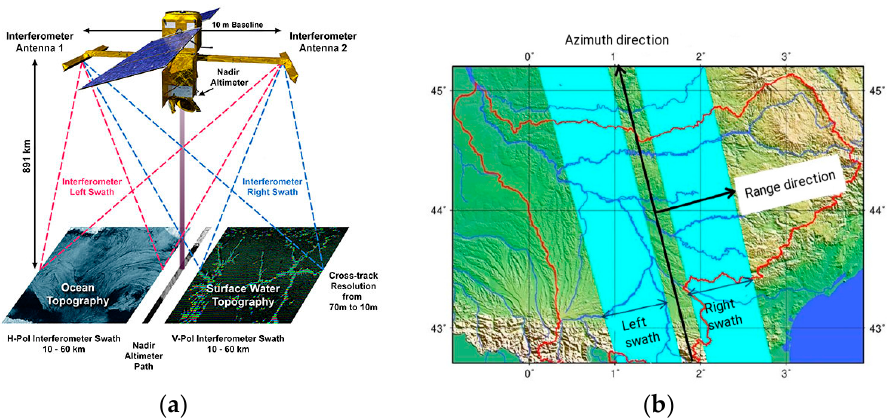
Figure 2. ( a ) Illustration of SWOT (© NASA-http://swot.jpl.nasa.gov/): The widths of the two rectangles represent two swaths of 50 km wide, observed by the two antennas of the satellite. They can observe either ocean or continental open water surfaces. ( b ) Illustration of the left and right swaths of SWOT, with the range direction perpendicular to the satellite track (which is the azimuth direction).